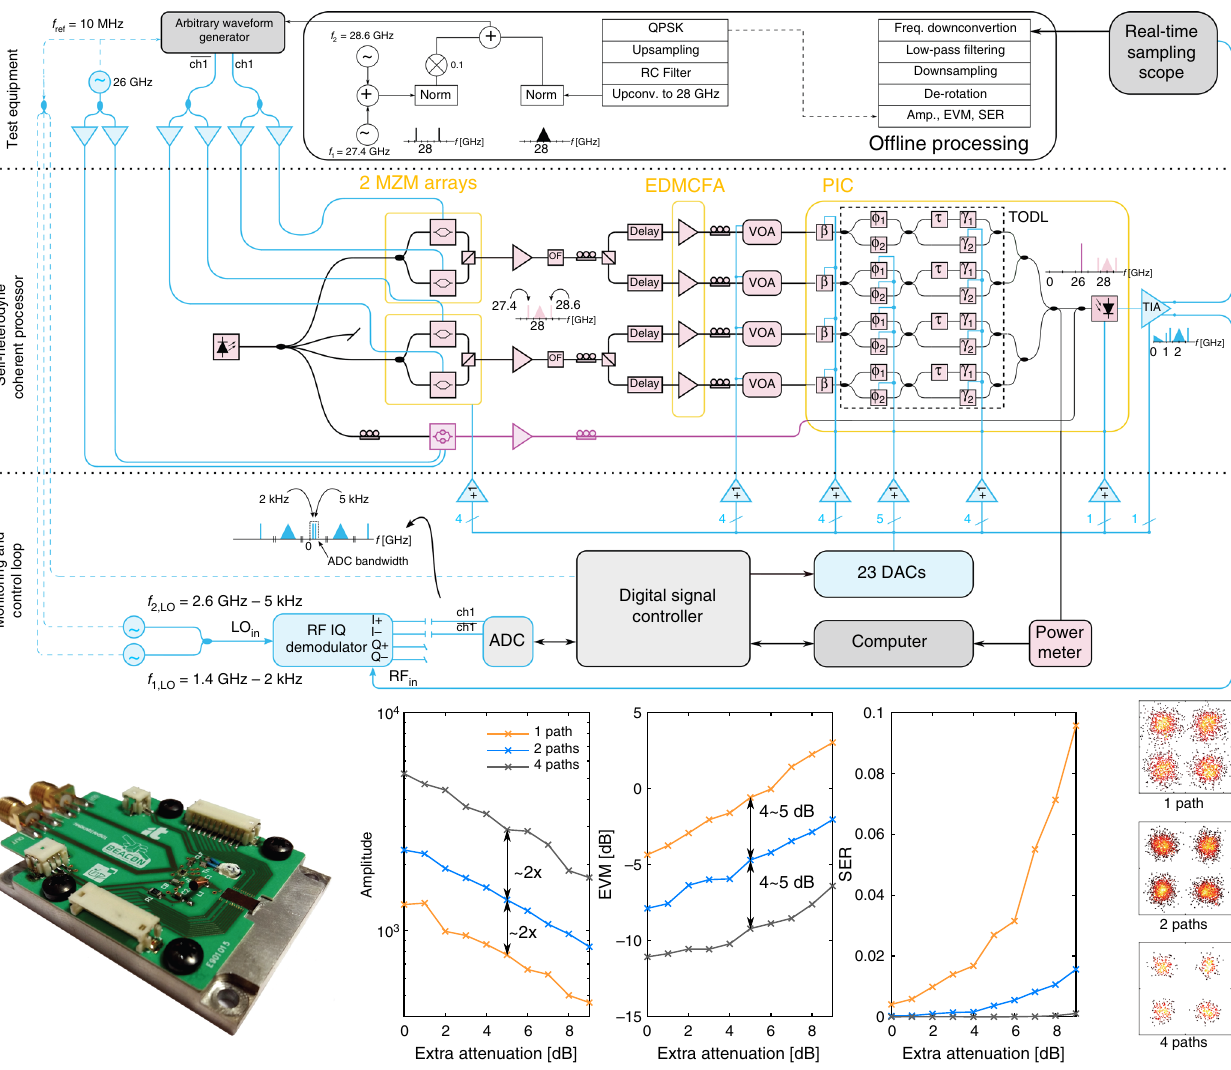
Fig. 2 Set up and characterization results of the proposed photonic processor. a Experimental set-up. b The photonic integrated circuit (PIC) is bond-wired to a printed circuit board (PCB), which provides lateral direct current (DC) access to the phase shifters and to a thermistor, and two radio frequency (RF) connectors for accessing the differential outputs of the transimpedance ampli fi ers (TIA). The pads of the germanium photodiode (Ge-PD) are bond-wired to a bias tee, which interfaces the photodiode with the transimpedance ampli fi er (TIA). c Amplitude, error vector magnitude (EVM) and symbol error rate (SER) of the output signal obtained when adding one, two and all four signals. d Representative constellation diagrams of the output signal obtained without extra